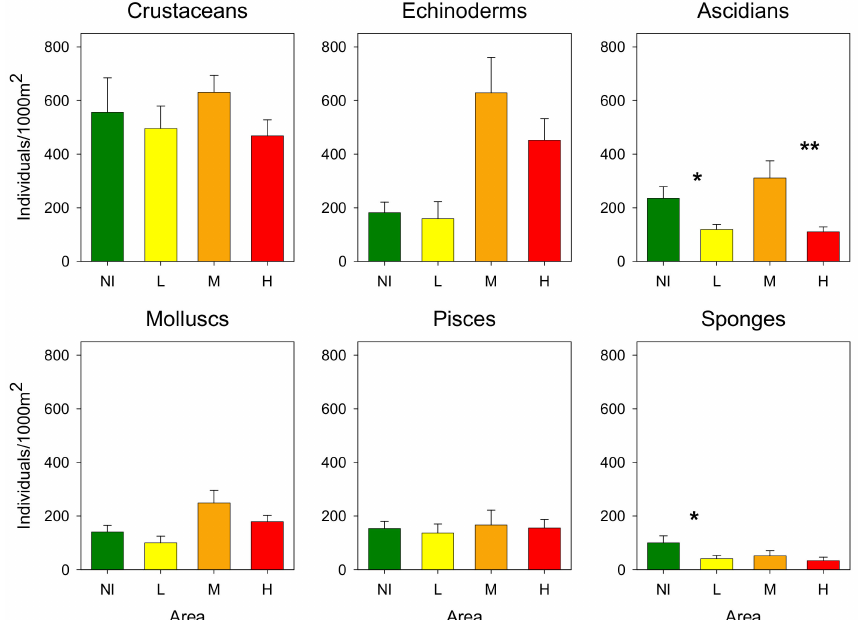
Figure 4. Mean values and standard errors of abundance (individuals/1000 m 2 ) for the main taxonomic groups, estimated from beam trawl samples in the four areas considered: Non-impacted (NI), Low effort history (L), Medium effort history (M), and High effort (H). p -values of the Student’s